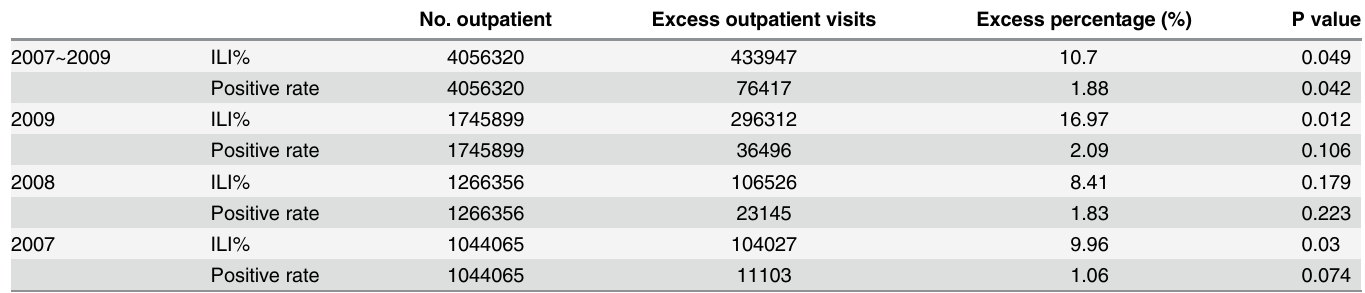
Table 3. Impact of influenza-like illness and influenza on outpatient